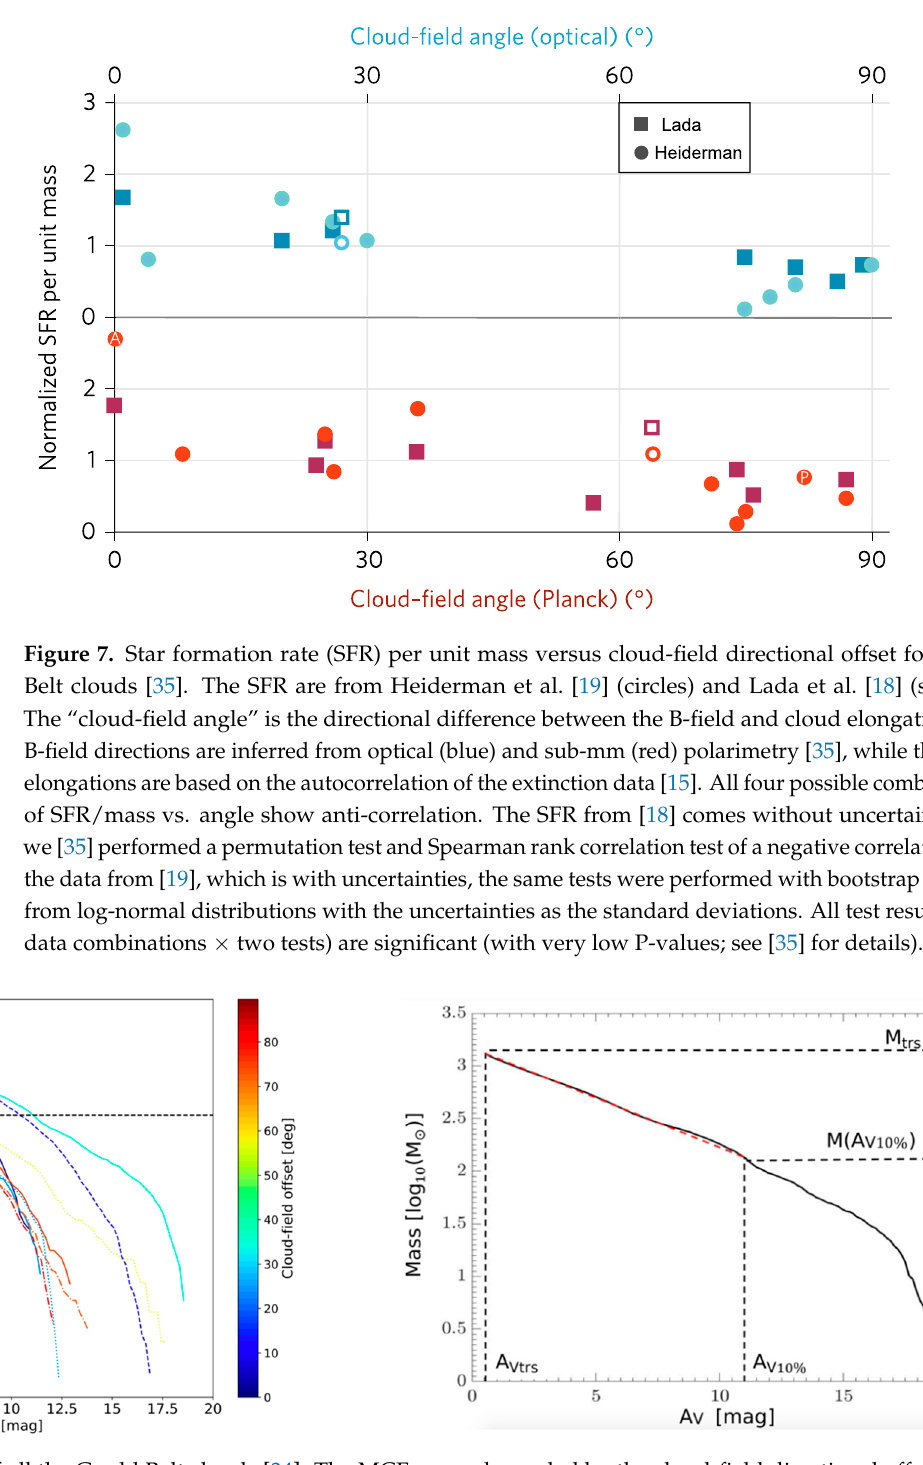
Figure 9. MCF slopes vs. cloud-field orientation offsets. Each symbol is color coded by the cloud distance (to show that resolution is not the cause of the trend). The cloud-field orientation offsets and the interquartile ranges (not the errors of the means) are adopted from [35]. The MCF uncer- tainties (vertical error bars) were defined in [34]. Perseus and Orion A/B (dotted lines) have more extensive line-of-sight scales and the largest discrepancies between the B-field directions inferred from Planck and optical data (Figure 6). The statistical tests summarized in Figure-7 caption were also performed here for a significant positive correlation [34]. 4. Turbulence-Field Interaction 4.1. Turbulence Anisotropy Given that cloud fields are ordered, turbulent velocities should be anisotropic. Tur- bulent energy cascades more easily in the direction perpendicular to the mean field than in that aligned with the field; see [36] for a short review. Heyer et al. [37] first observed turbulence anisotropy in a ~2° × 2° diffuse region in the Taurus Molecular Cloud (TMC), where A v is less than 2 mag. Heyer and Brunt [4] extended the study of [37] to higher density using 13 CO (1–0) lines, which traces A v = 4–10